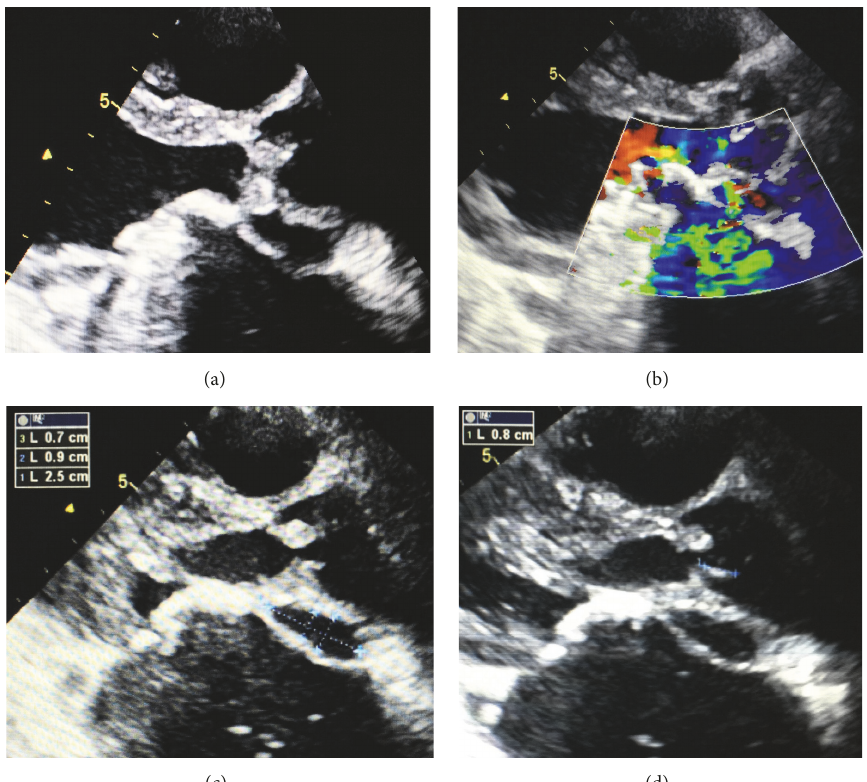
Figure 2: TTE: parasternal long axis view showing aortic periannular abscess communicating with the left atrium without (a, c) and with color Doppler imaging (b) and aortic vegetation (d).